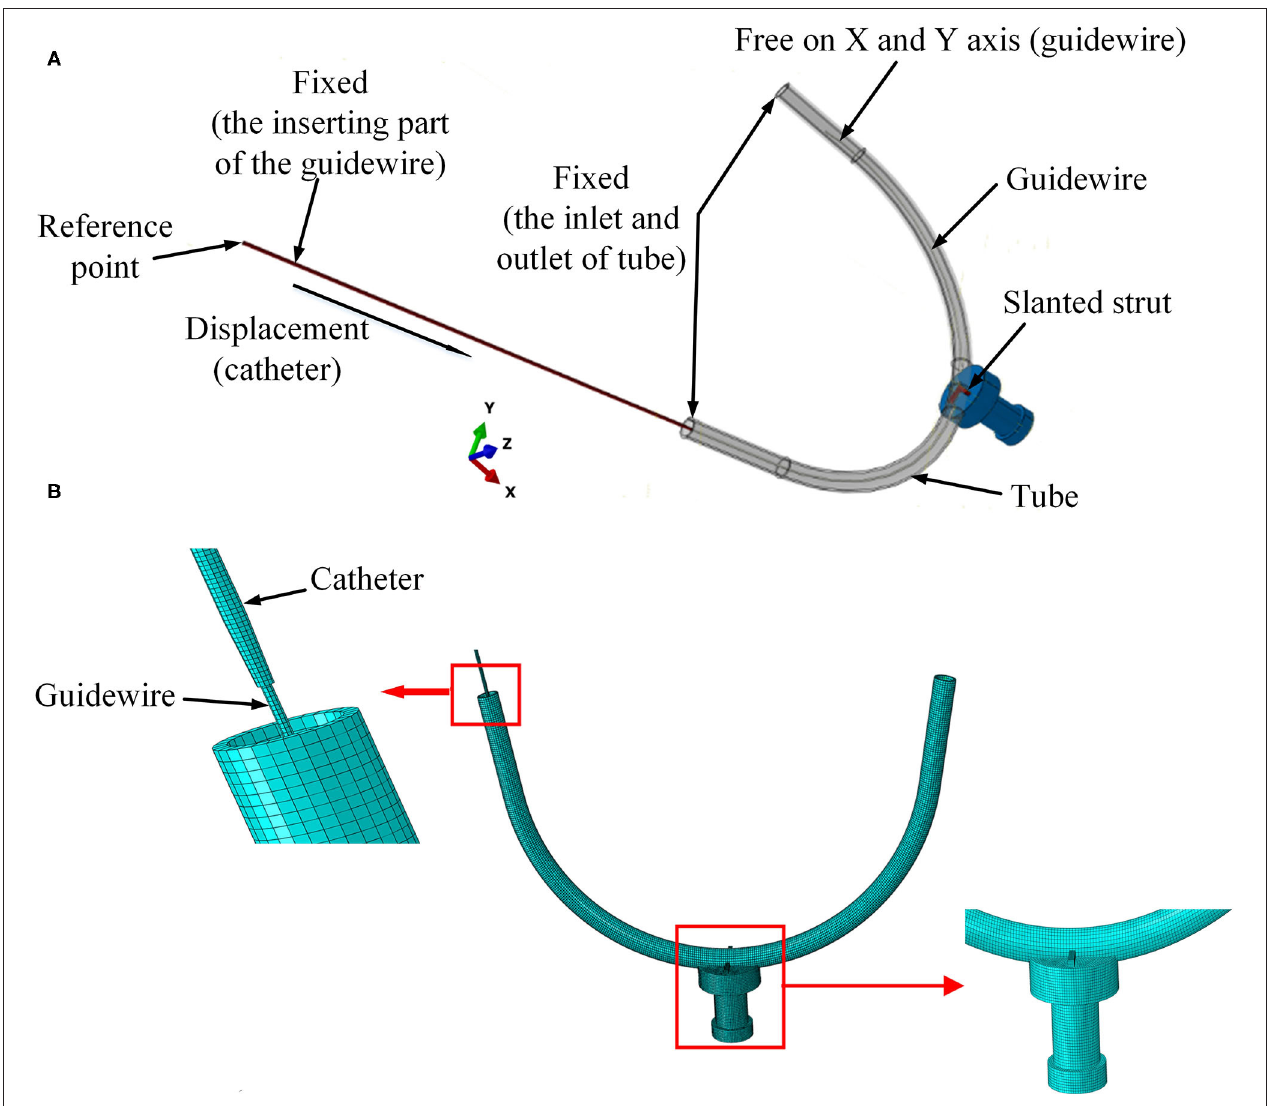
FIGURE 4 | Setup of experimental FE model. (A) Boundary conditions for the FE model and (B) mesh of the 3D FE model.